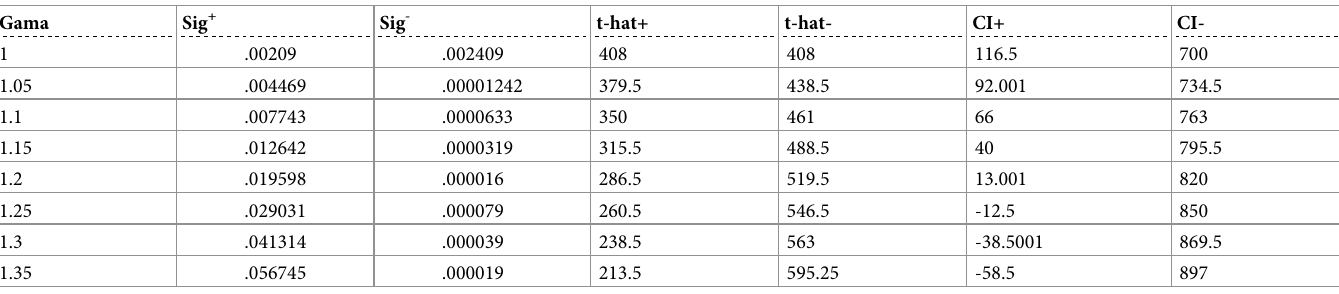
Table 12. Food security sensitivity analysis